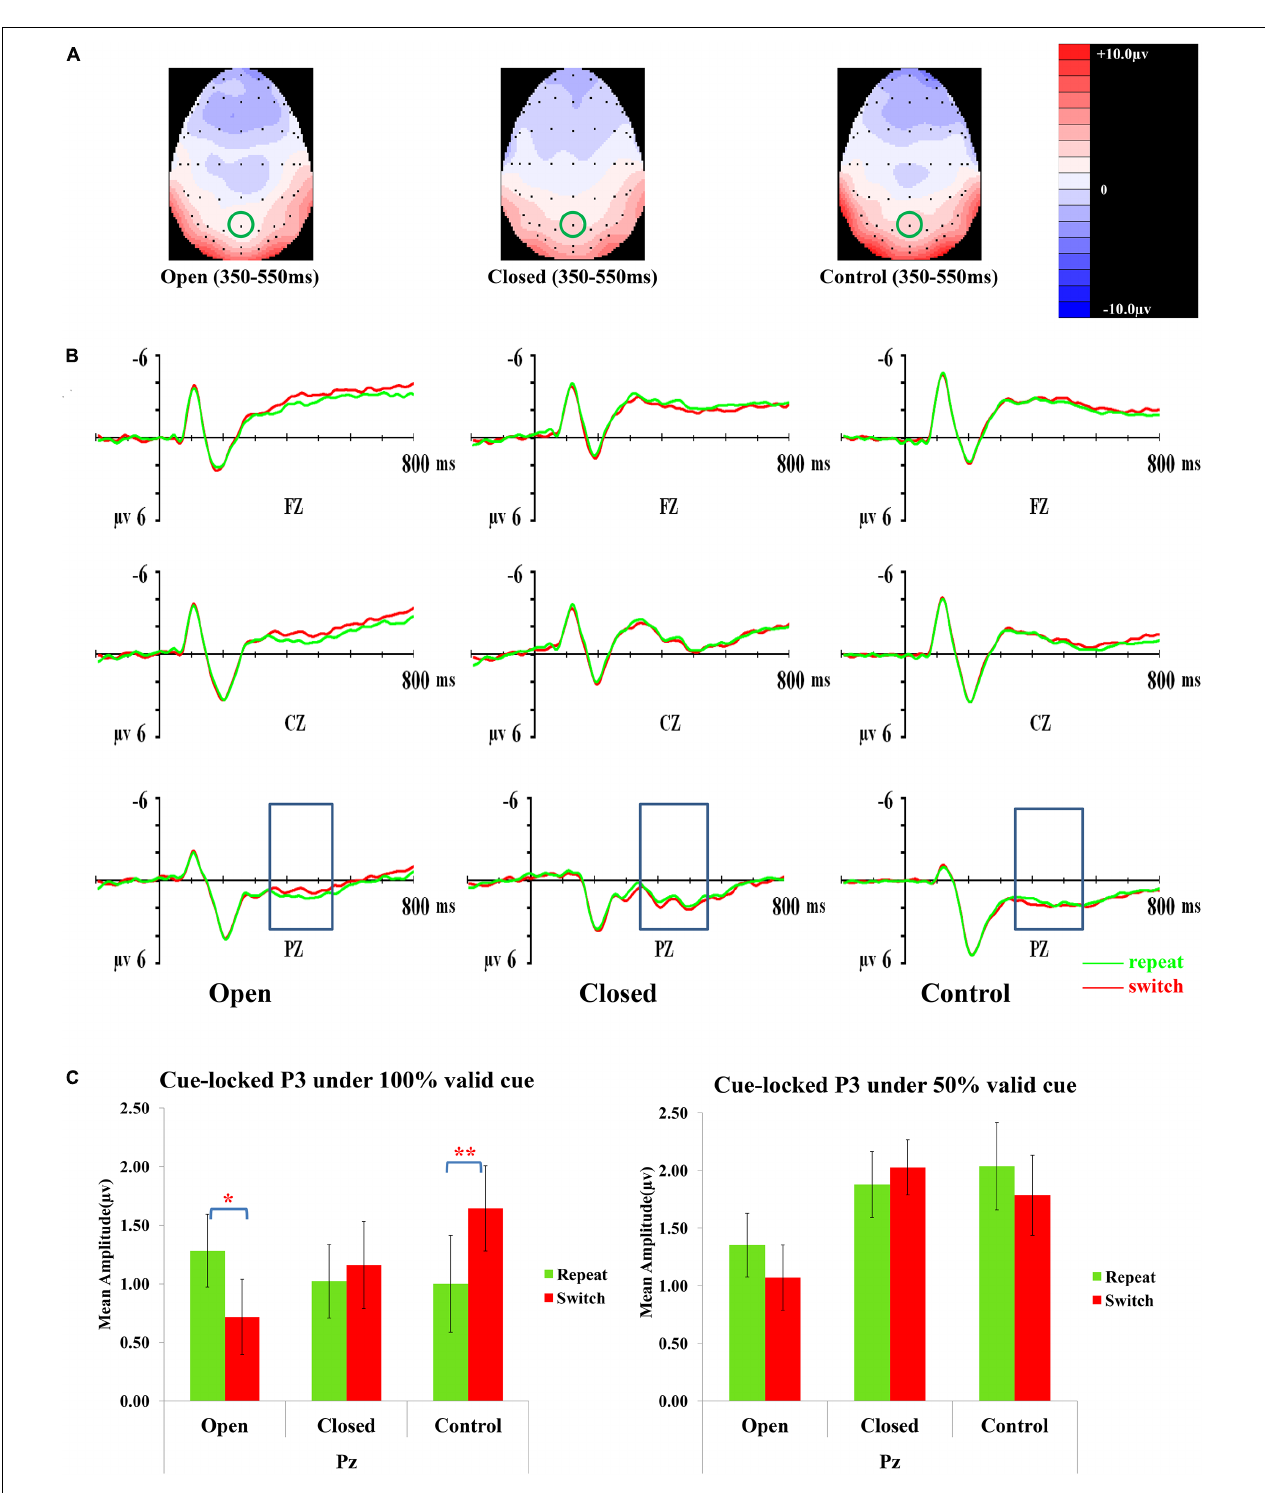
FIGURE 3 | Analyses of the cue-locked P3 among three groups of participants. (A) Topographical distributions within the 350–550 ms post-cue time-window regardless of trial types and validities; the Pz site is indicated with the green circle. (B) Mean amplitudes of the waveforms of the repeat (in green) and switch (in red) trial-types regardless of validities; the 350–550 ms time-window at Pz is indicated with the rectangular boxes. (C) Comparisons of the mean amplitudes between the repeat and switch trial-types at the Pz site for the 100% (left panel) and 50% (right panel) validity conditions. Error bars indicate SEM; ∗ p < 0.050; ∗∗ p < 0.010.